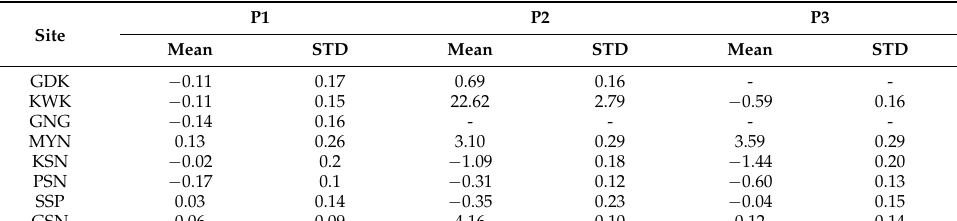
Table 4. Mean and standard deviation (STD) of RCA at each site. The periods are divided by the change in RCA.